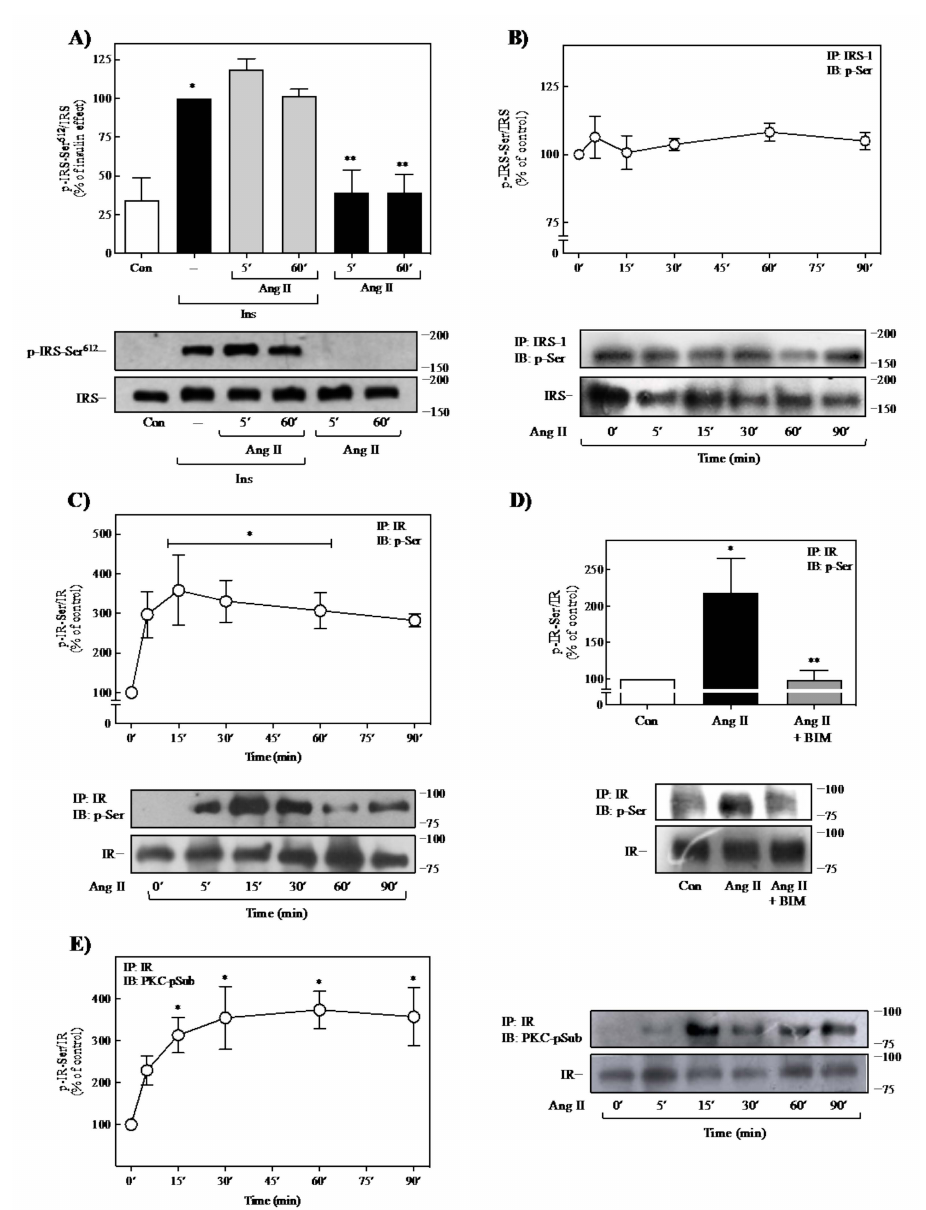
Figure 3. Ang II promotes IR-Ser-phosphorylation through PKC activation. ( A ) 3T3-L1 adipocytes were pretreated with or without Ang II for 5 or 60 min and then stimulated with 100 nM insulin for an additional 90 min. Cells were also exposed only to 100 nM Ang II for 5- or 60-min. Total cell lysates were separated by SDS-PAGE and analyzed by immunoblotting with anti-p-IRS-1-Ser 612 . ( B , C , E ) 3T3- L1 adipocytes were stimulated with 100 nM Ang II for the indicated times. Total cell lysates were immunoprecipitated with anti-IRS-1 ( B ) or anti-IR ( C , E ) antibody before SDS-PAGE analysis and immunoblotted with an anti-phospho-Ser antibody ( B , C ) or anti- phospho-(Ser) PKC substrate antibody ( E ). ( D ) Cells were pretreated with 2 µ M BIM for 30 min before treatment with 100 nM Ang II for 60 min. Cell lysates were immunoprecipitated with anti-IR antibody before SDS-PAGE analysis and immunoblotted with an anti-phospho-Ser antibody. Under all experimental conditions, cells without treatment were considered as controls. Blots were quantitated by densitometry, and the mean values were plotted from three-five independent experiments. Vertical lines represent the S.E.M. Representative immunoblots are presented ( B – D ). Western blots were also probed for total IRS ( A , B ) and IR ( C – E ) and used for data normalization. ( A ) * p < 0.05 vs. Con; ** p < 0.05 vs. Ins (–). ( C ) * p < 0.05 and vs. time 0 (cid:48) . ( D ) * p < 0.05 vs. Con; ** p < 0.05 vs. Ang II. ( E ) * p < 0.05 vs. time 0. BIM, BIM I; Con, control; Ins,